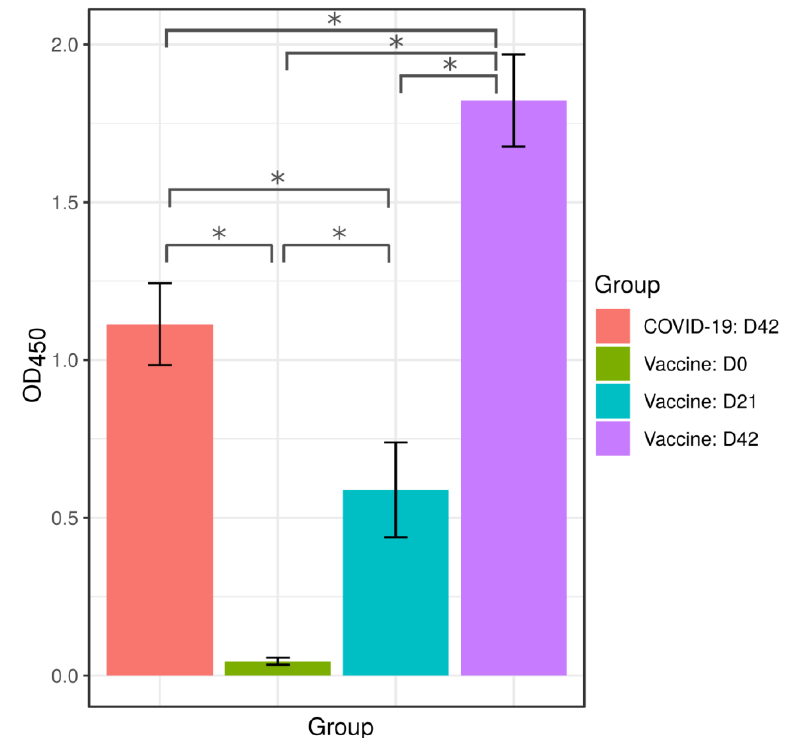
Figure 1. Analysis of anti-SARS-CoV-2 antibodies in sera of convalescent COVID-19 and SputnikV immunized individuals. SputnikV immunized sera (40 samples) were collected on Day 0 (D0; green bar), Day 21 (D21; blue bar) and Day 42 (D42; purple bar) after immunization. Sera from convalescent COVID-19 patients (40 samples; red bar) were collected between 32 and 65 days after the first symptoms (median 42.0 ± 11.1 days). Anti-SARS-CoV-2 IgM, IgG and IgA antibodies were detected using the Coronapass ELISA kit (BioPalitra, NextGene Russia). Sera from the same individuals before immunization was used as control. Data are presented as Mean ± SEM (standard error of the mean). Y-axis shows OD 450 values (Coronapass ELISA kit; BioPalitra, NextGene Russia * statistical significance).